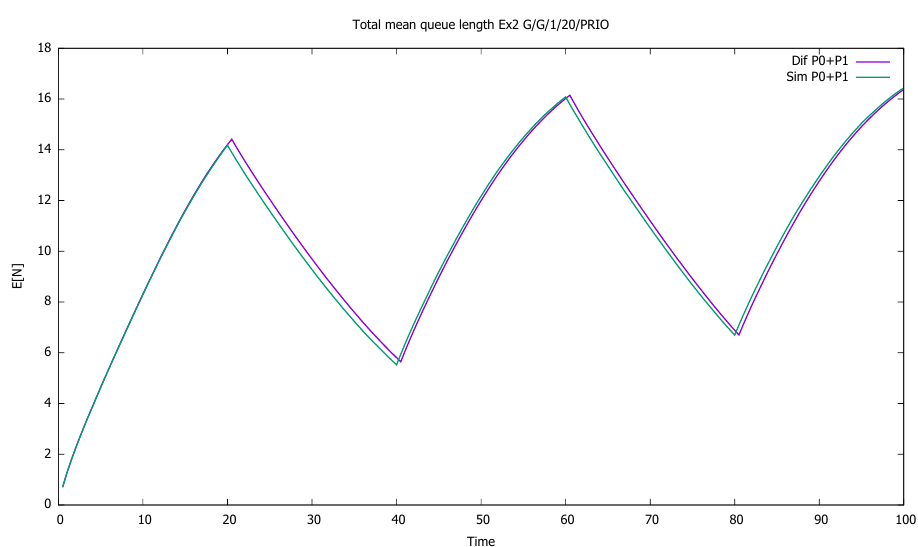
Figure 6. Section 3.2, medium load: total mean queue length for both classes together. The changes in the system highly affect the probability of both empty (Figure 7) and full (Figure 8) queues of classes 1 and 2. Again, the observation starts with an empty queue, but this time the probability of an empty queue for non-priority drops to zero. Moreover, the probability that the saturated non-priority queue increases with each cycle is grows a little bigger, signaling that the system will saturate in the future.